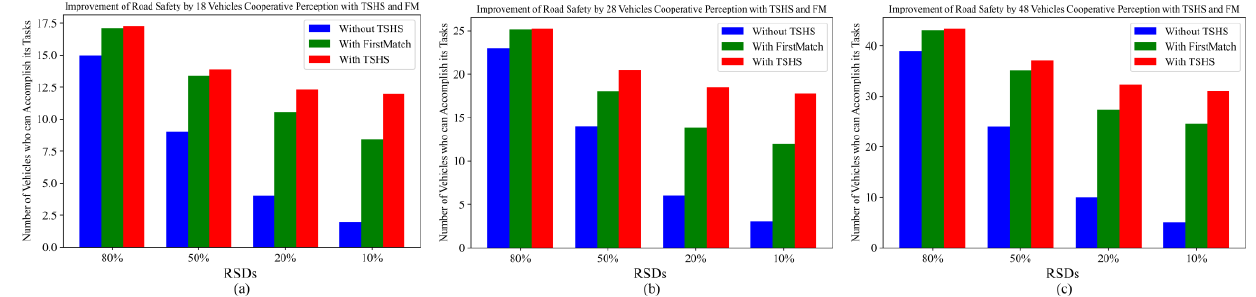
Figure 10. Average number of vehicles whose tasks can be completed under different RSDs. ( a ) Cluster scale is 18. ( b ) Cluster scale is 28. ( c ) Cluster scale is 48.